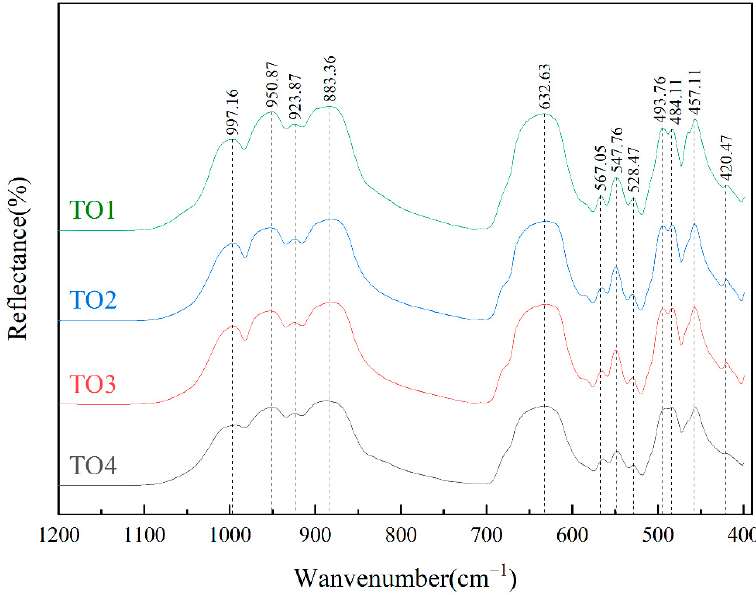
Figure 4. Infrared reflection spectra of yellow topaz samples (380–1200 cm − 1 ).